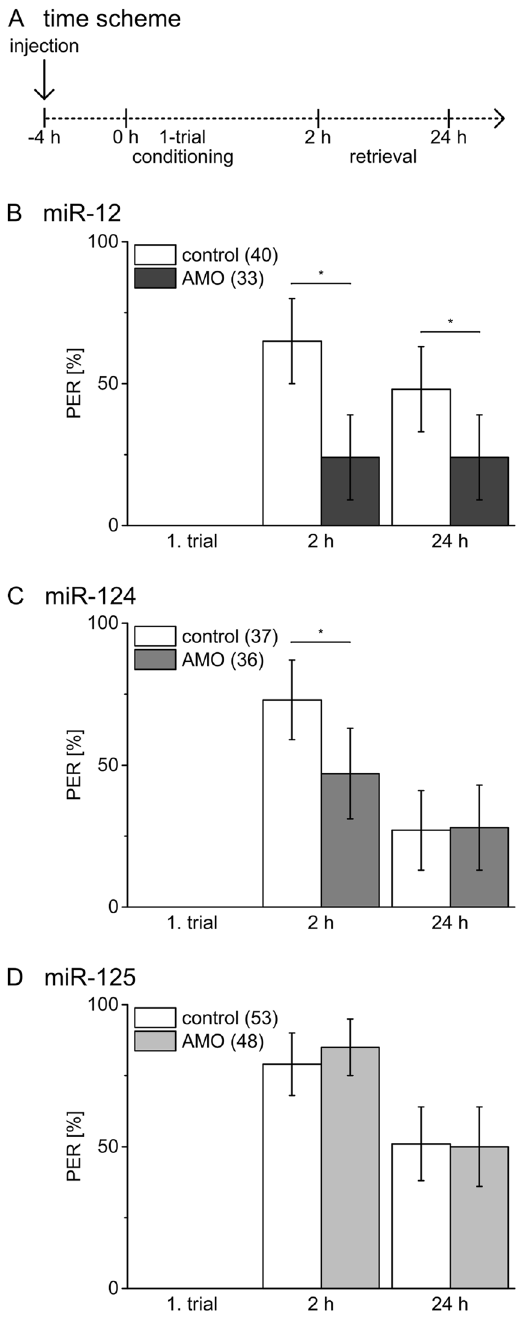
Figure 2. Inhibition of miRNAs before 1-trial conditioning has distinct effects on early memory phases. ( A ) Four hours before 1-trial conditioning bees were injected with inhibitors (AMO) for miR-12 ( B ), miR-124 ( C ), miR-125 ( D ) or PBS (control). Columns show the percentage of bees reacting with PER to odour presentation during conditioning and retrieval tests 2 h and 24 h after conditioning. The error bars indicate 95% binominal confidence interval and the numbers of tested animals per group are indicated in brackets. Asterisks show significant differences between groups (Chi-square/Fisher exact test (two-tailed) p < 0.05 details in